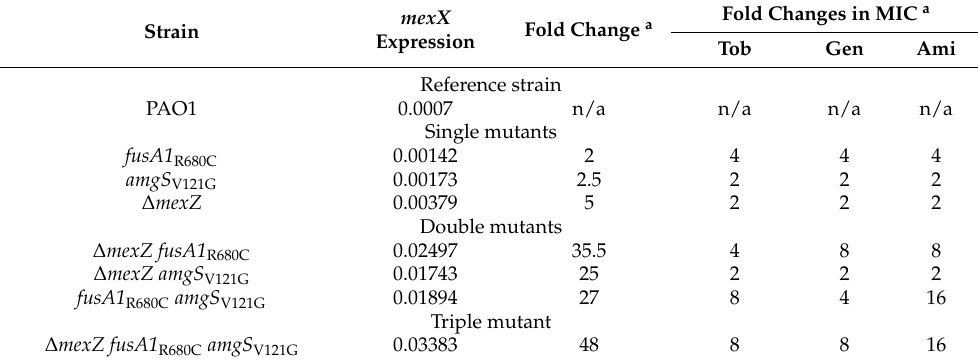
Table 3. The effect of mutations on mexX